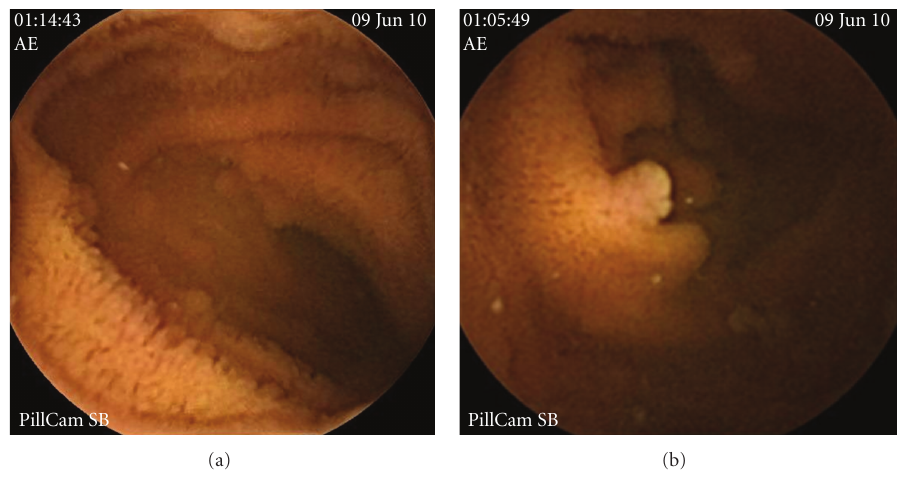
Figure 1: CE detected small-sized ( < 5) (a) and medium-sized (5–10mm) (b)